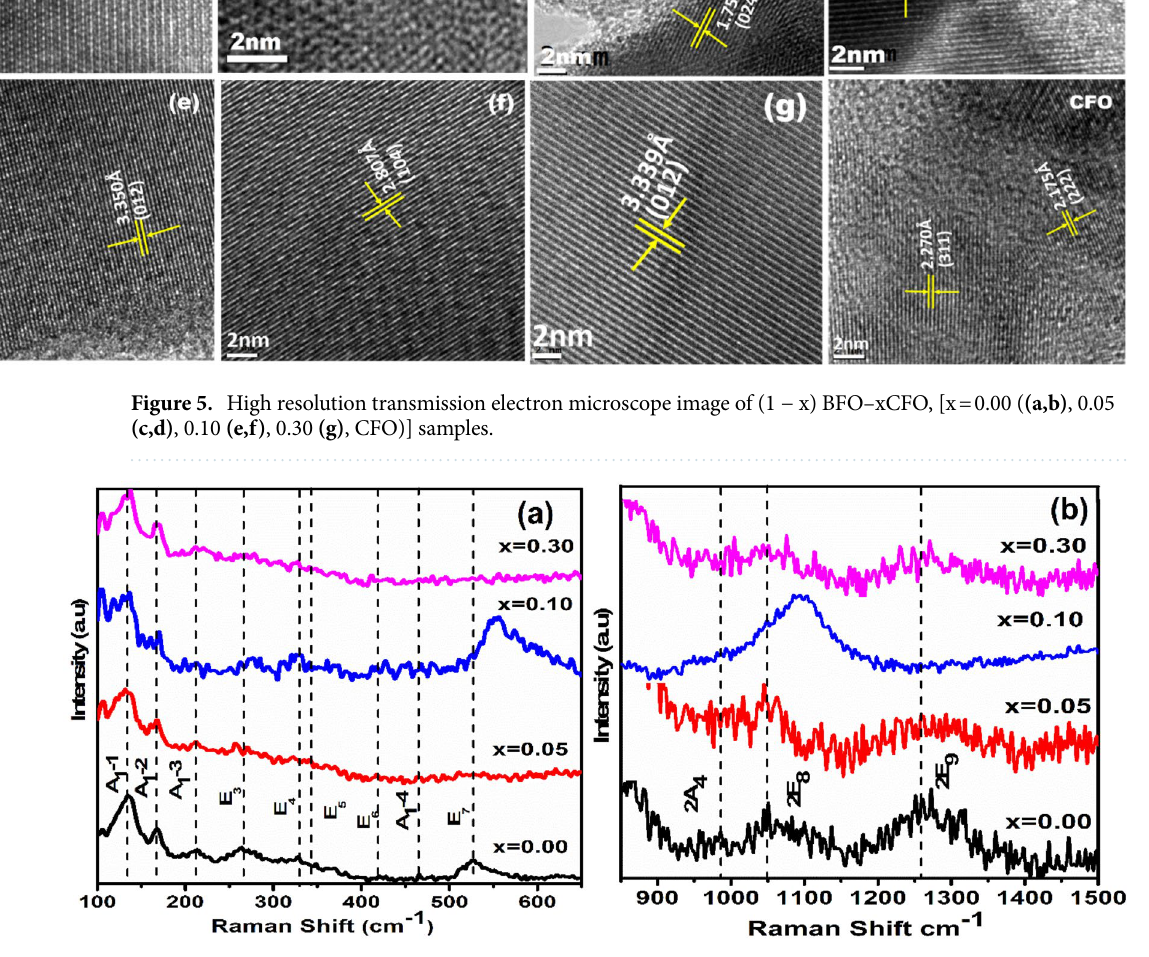
Figure 6. (a) Raman spectra in the range between 100 and 650 cm −1 at room temperature and (b) two phonon modes in the range of 850–1500 cm −1 of (1 − x) BFO–x CFO (x = 0.00, 0.05, 0.10 and